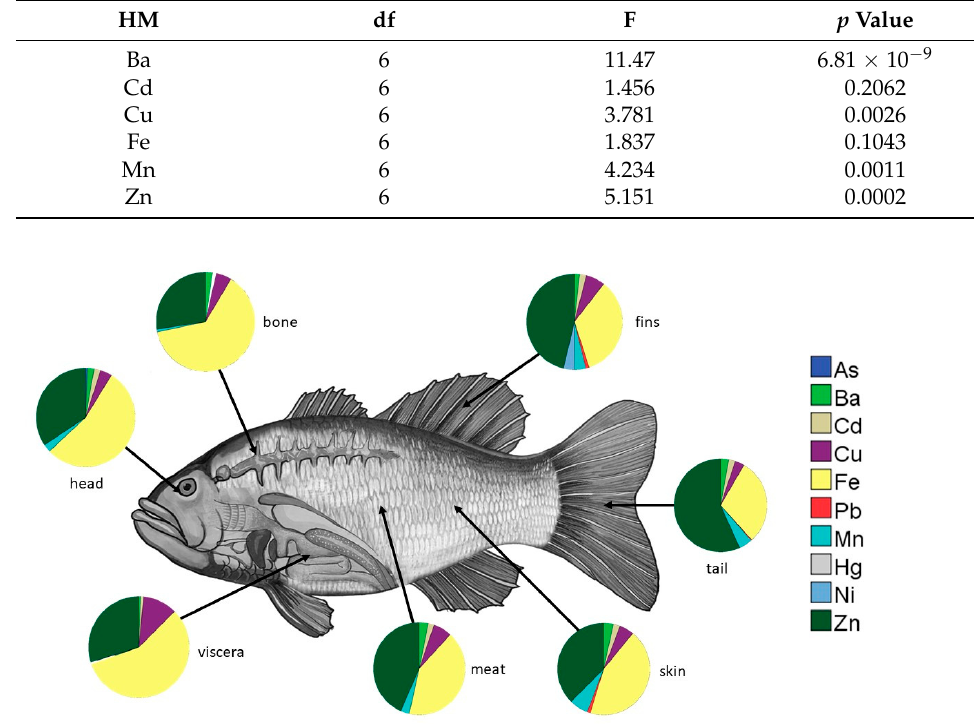
Table 5. One-way ANOVA of the HMs in various parts of Tilapia spp.